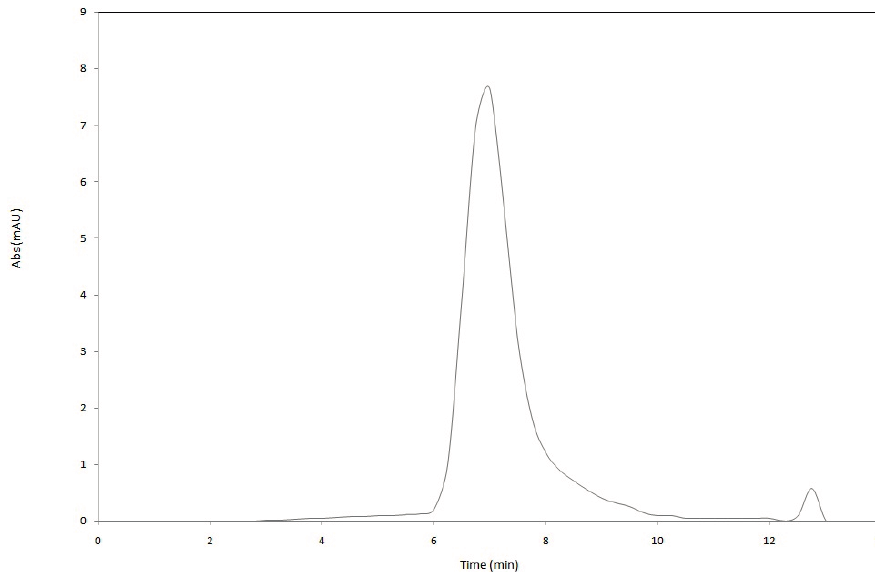
Figure 6. Representative HPLC chromatogram of extracted astaxanthin from the gelatin/SC stabilized